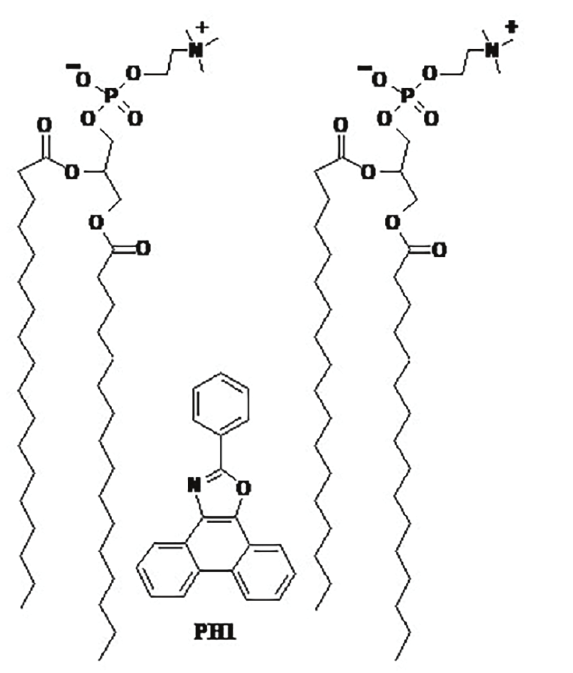
Figure 1. The figure demonstrates localization and orientation of fluorescent probe PH1 in phospholipid membranes. Two molecules of phosphatidylcholine from the outer leaflet are shown to denote the localization of the probe (Adapted from Ref